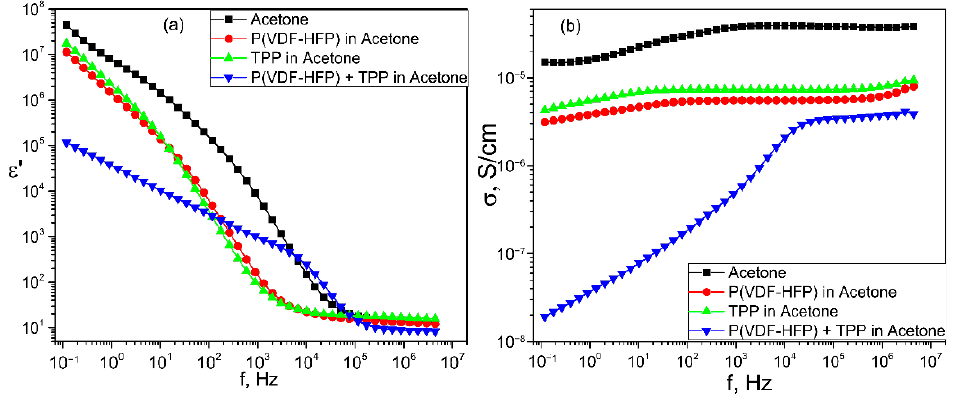
Figure 8. Frequency dependences of dielectric permittivity ε ′ (f) ( a ) and conductivity σ (f) ( b ) of acetone and in its solutions with TPP, pure copolymer and of mixed solution of P(VDF-HFP) and TPP.